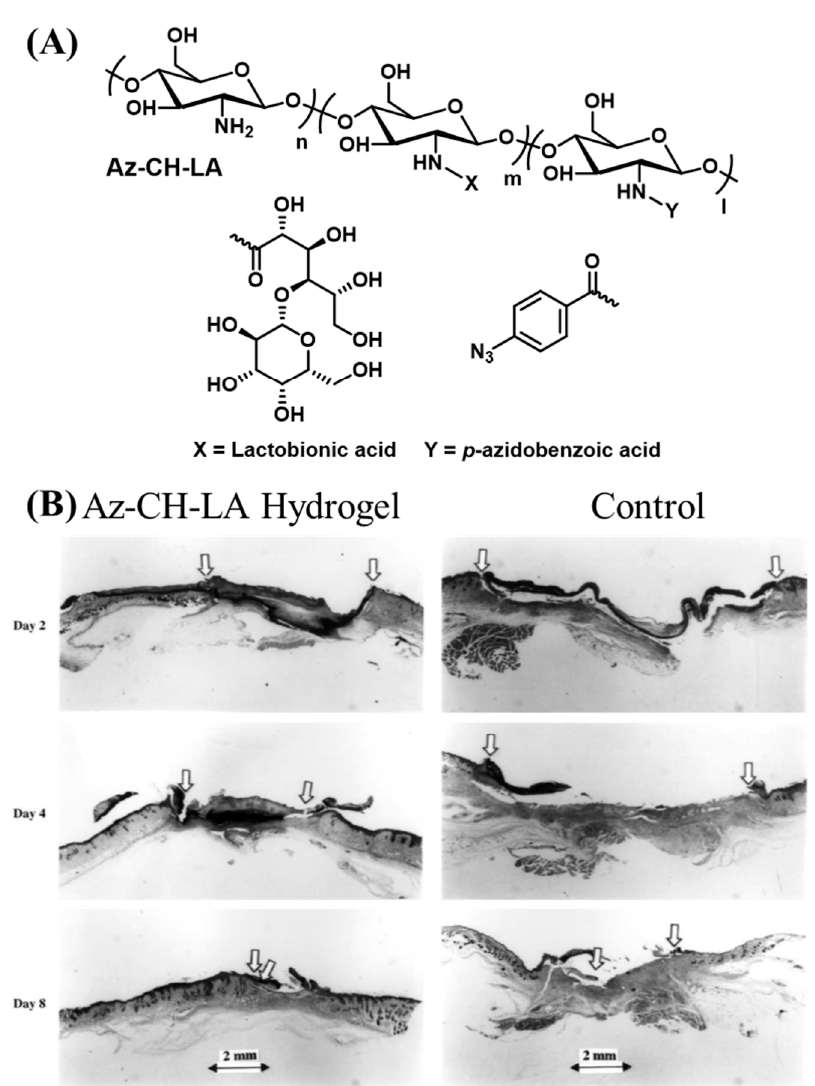
Figure 4. ( A ) Schematic representation of the chemical structure of Az-CH-LA [67]. ( B ) Histological examination of wound repair of Az-CH-LA hydrogel-treated (left) and control wounds (right) [69]. Copyright 2001, reproduced with permission from Elsevier.